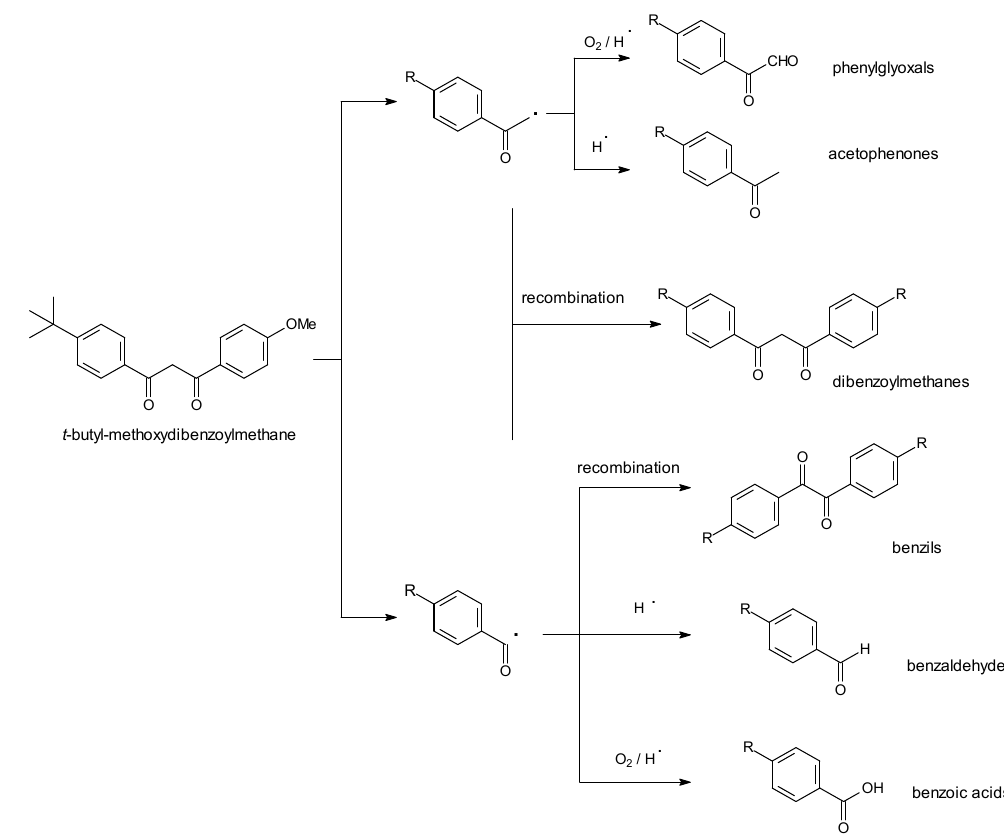
Figure 2. Photodegradation of dibenzoylmethanes (adapted from Schwack et al. [11]).